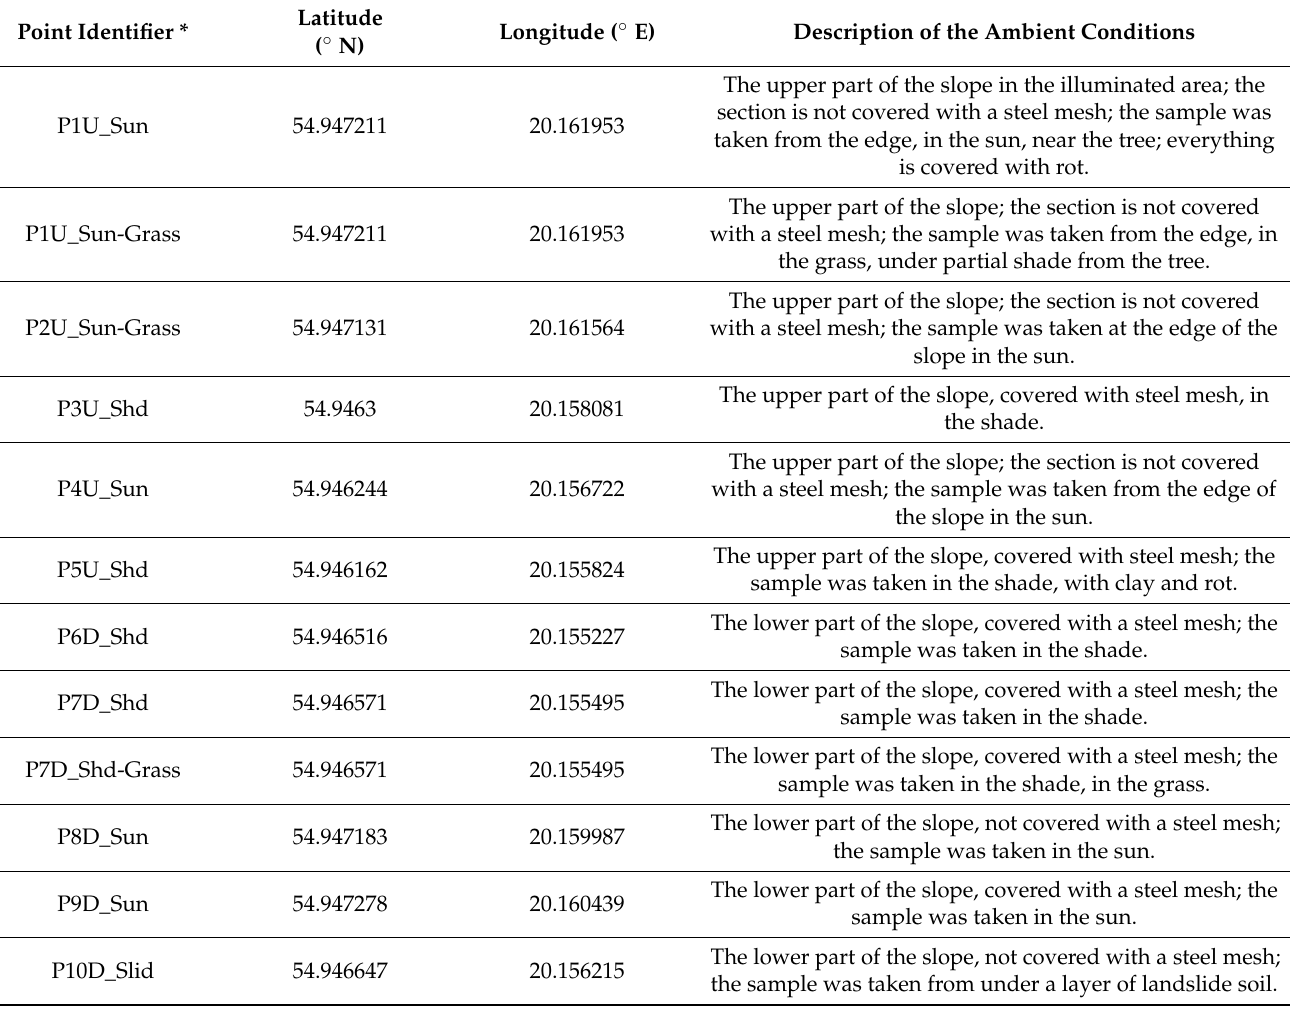
Table 1. Sampling points (Figure 5) and operating conditions, including lighting situation (exposure to sunlight or